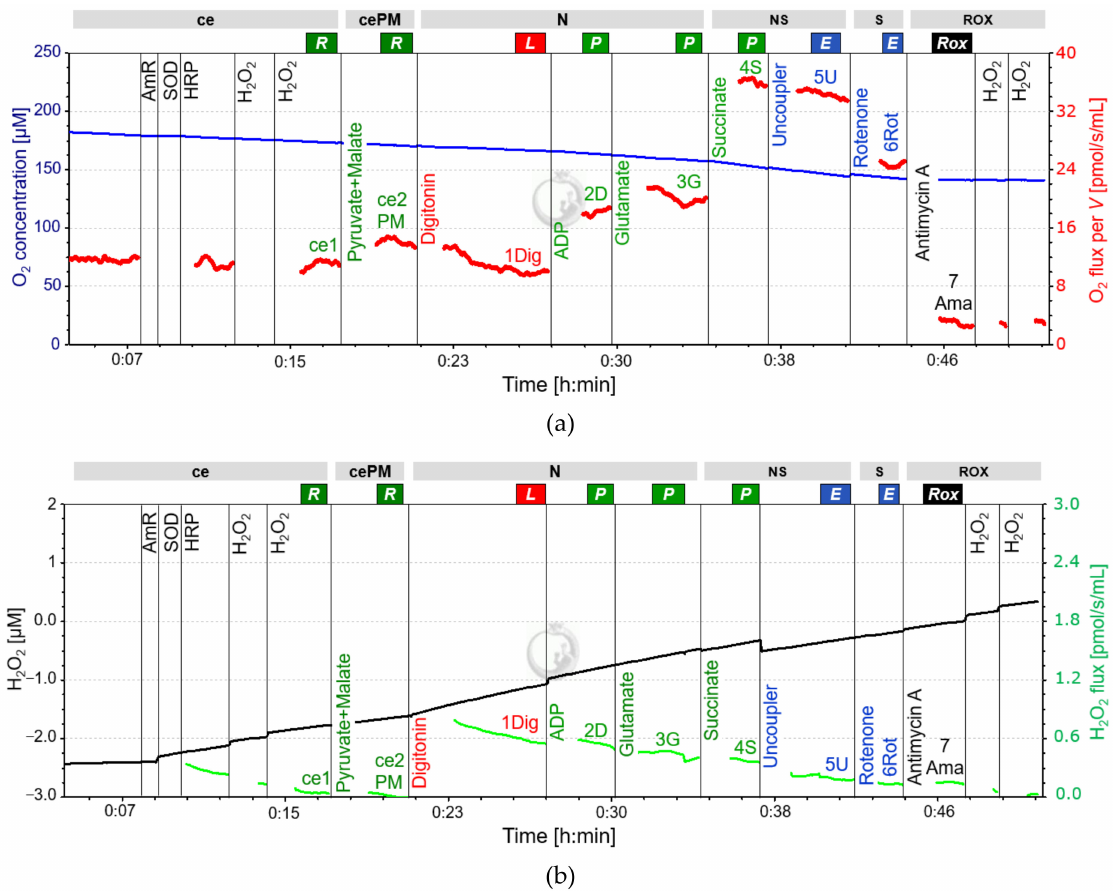
Figure 2. Representative fluo-respirometric trace following SUIT 8 protocol. ( a ): The blue line shows the O 2 concentration [ µ M] measured at 2-second time intervals, the red line represents the volume-specific O 2 flux [pmol/s/mL] as described in Figure 1. The volume-specific flux shows instability in relation to the experiment of Figure 1, starting at the point of the first chemical titrations. The decrease in O 2 flux from NS(PGM) P to NS(PGM) E is intensified compared to Figure 1. The time interval between titration of ADP and G was too short to determine N(PM) P . ( b ): The black line is the amperometric signal, converted from the raw data of fluorescence to the total concentration of AmR [ µ M] after calibration with H 2 O 2 . The amperometric signal is characterized by an average increase over time with slight stepwise changes induced by titrations. The green line represents the calculated H 2 O 2 flux per volume [pmol/s/mL]. The digitonin titration causes a burst in H 2 O 2 release, slowly decreasing over time, but masking possible changes in H 2 O 2 release. The representative experiment was performed in the laboratory of Oroboros Instruments. Abbreviations: ce, presence of the sample (cells); cePM, presence of the sample, pyruvate and malate; N, N-pathway: NADH electron transfer-pathway state; NS, NS-pathway: CI&CII linked electron transfer-pathway state; S, S-pathway: succinate-linked (CII-linked) electron transfer-pathway state; ROX, Residual oxygen consumption; R, Routine state; L, Leak state; P, Oxidative Phosphorylation (OXPHOS); E, Electron transfer pathway (ET); ADP, adenosine di-phosphate; AmR, Amplex UltraRed; SOD, Superoxide Dismutase; HRP, Horseradish Peroxidase; H 2 O 2 , Hydrogen